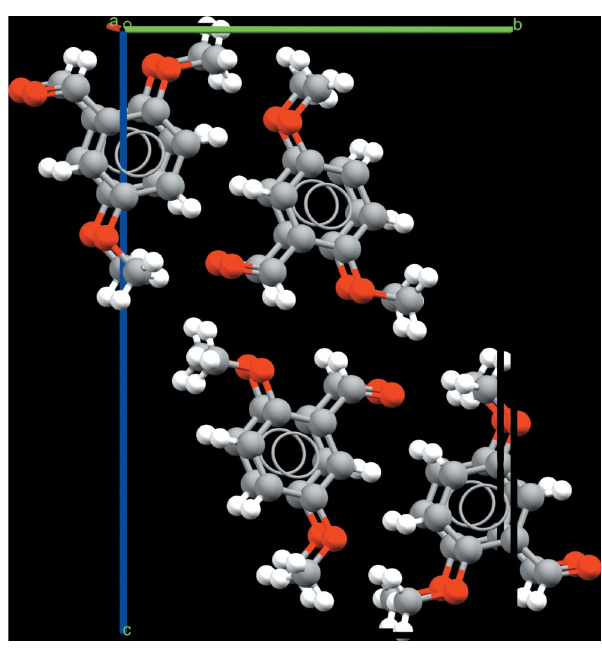
Figure 6 Aview along the b axis of the crystal structure of 2,4-DMBz, in which (cid:2) – (cid:2) stacking interactions between the aromatic rings are present.